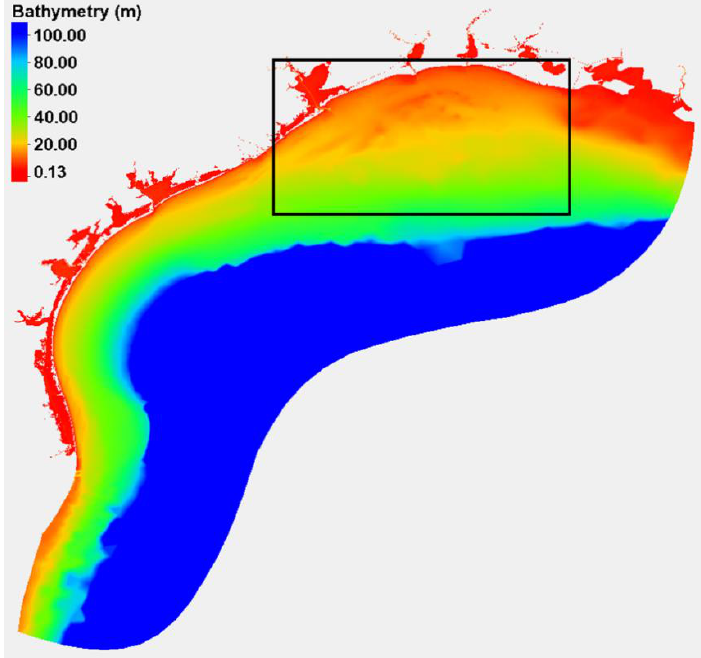
Figure 12. The concave geographic shape and shallow bathymetry characteristics of the northern Texas-Louisiana shelf within the black box. Texas-Louisiana shelf within the black